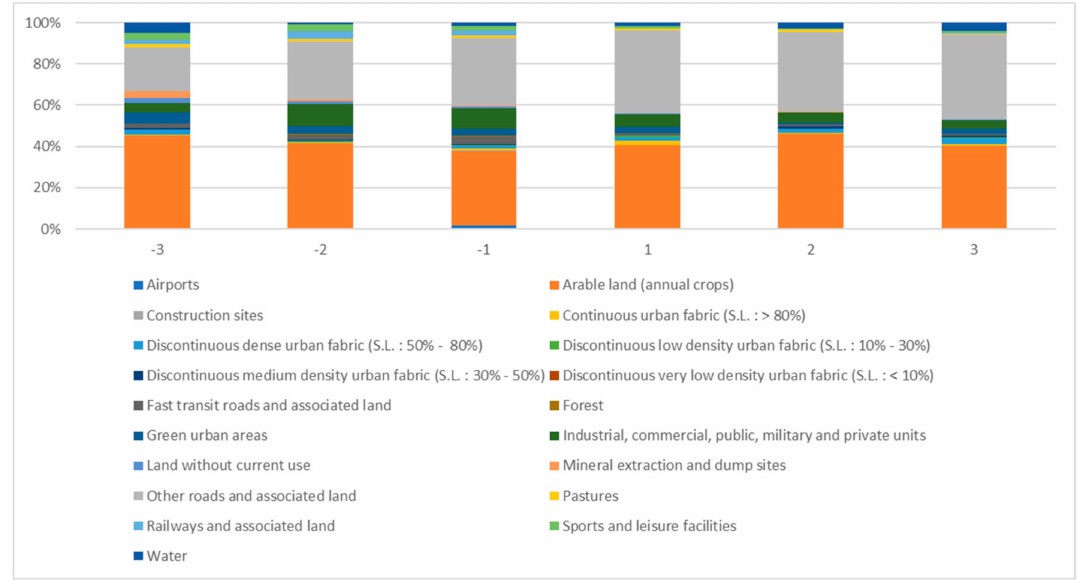
Figure 19. Ratio comparison of the land use dataset contained by hot/cold spots